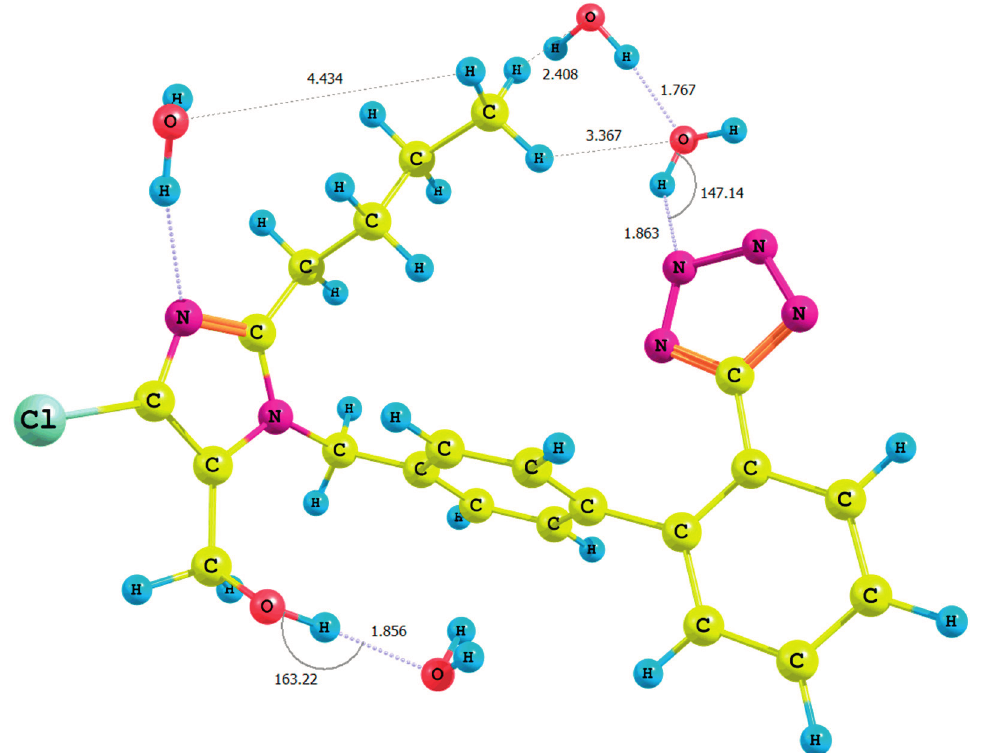
Figure 3. Optimized structure of the syn -losartan anion cluster 1 with water molecules (Rotamer X ); interaction of 1 with three water molecules (PBE1PBE/6-31G(d,p) level of theory,